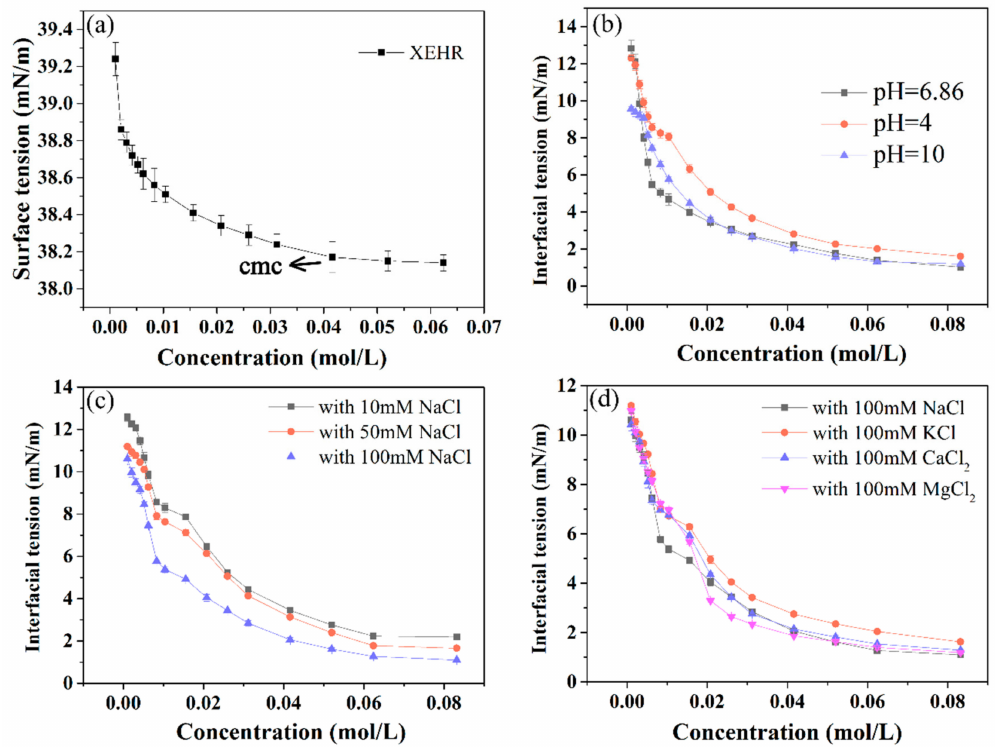
Figure 5. The surface tension curves for ( a ) XEHR in pure soybean oil, and for XEHR in oil / soybean mixtures showing the e ff ects of ( b ) pH, ( c ) salt concentration, and ( d ) salt